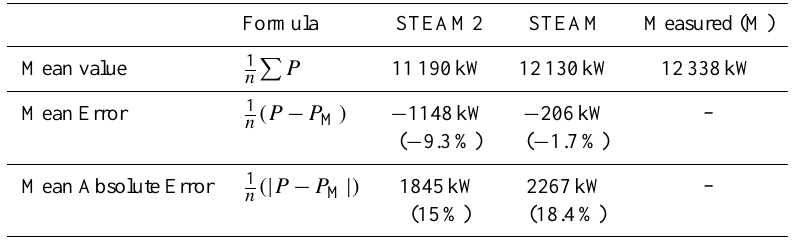
Table 1. Statistical measures for the power predictions of STEAM and STEAM2. P is the predicted power, P M is the measured power and the number of observations n = 729. Errors in percent in the table have been computed with respect to the mean values of the measurements.